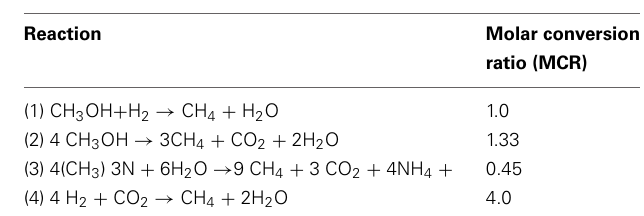
Table 3 | Methanogenic consumption of methanol (reactions 1 and 2), TMA (reactions 3), and hydrogen (reaction 4) and molar conversion